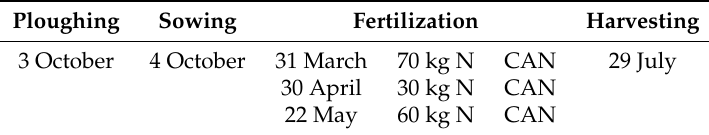
Table 2. Artificial crop management setting used for the sensitivity analysis, in which CAN was used as a calcium-ammonium-nitrate-based nitrogen fertilizer. The management steps were repeated for each cultivation year, starting in 2005. The dates of the management steps were made consistent for each study site to facilitate the analysis of the temporal SA